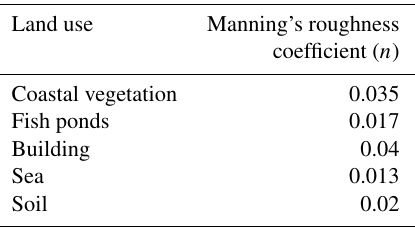
Figure 6. Distribution of Manning’s coefficients used in the sim- ulation for land use types in 2004 (before the 2004 Indian Ocean tsunami).